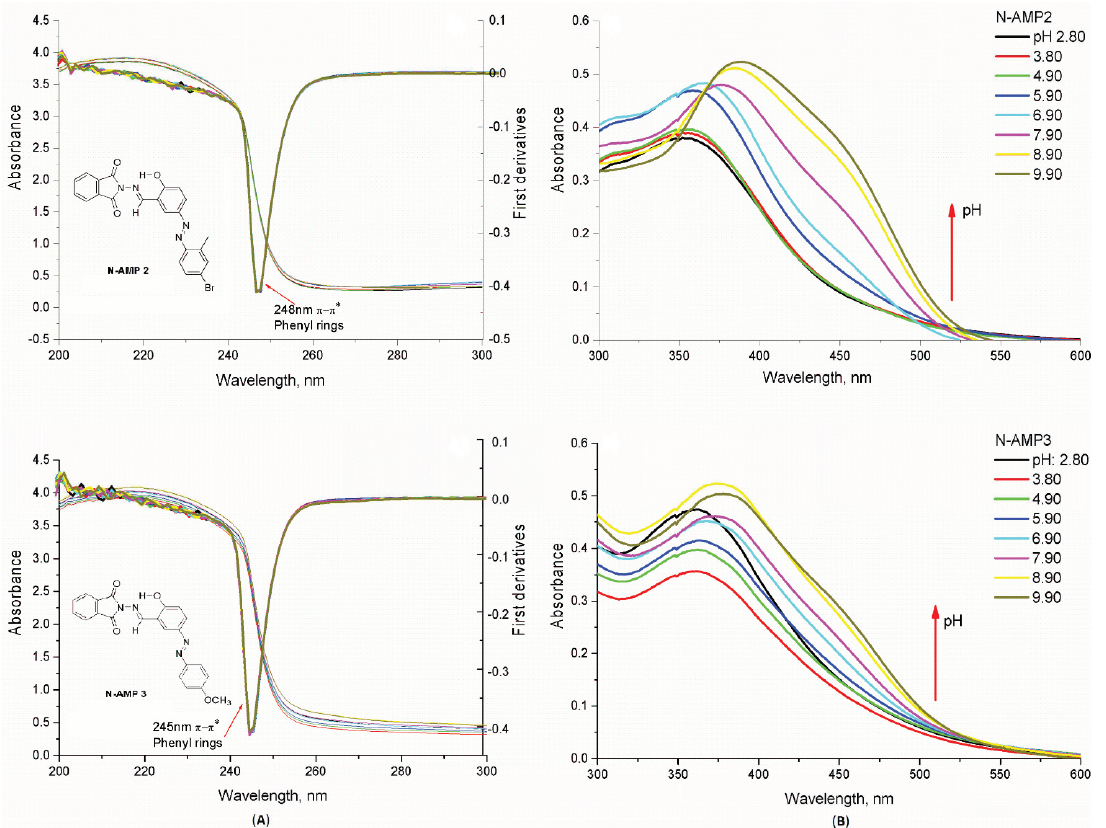
Figure 4. UV–Vis spectra of N-AMP2 (L2, C = 6.03 × 10 − 5 mol L − 1 ) and N-AMP3 (L3, C = 7.97 × 10 − 5 mol L − 1 ) at different pH (buffer Robinson, pH 2–11) and scaling as follows: ( A ) UV–Vis (zero) and differentiated spectra from 200 to 300 nm and ( B ) UV–Vis spectra from 300 to 600 nm.